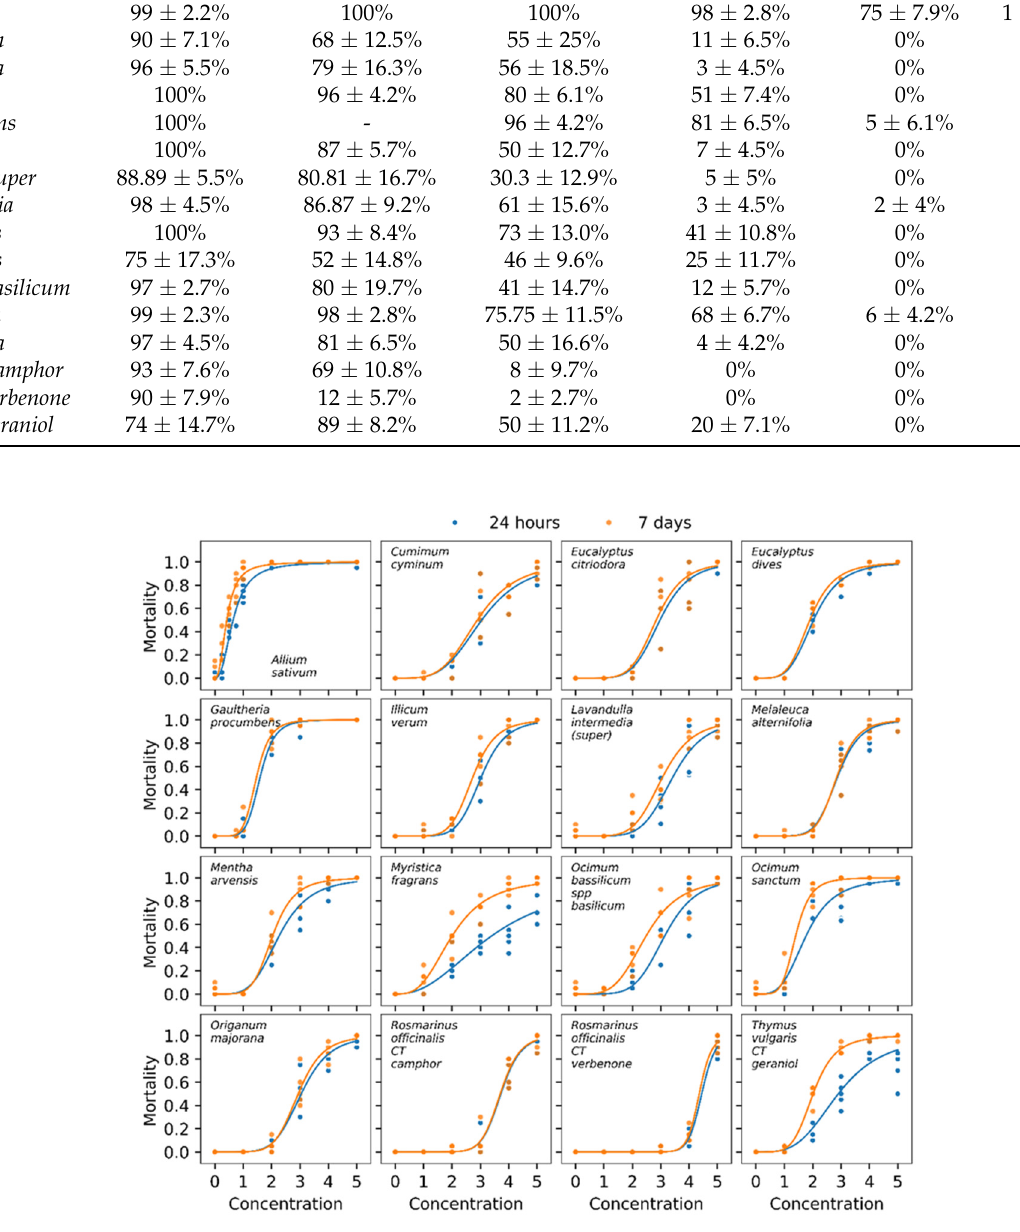
Figure 1. Mortality curves of EOs tested on S. granarius 24 h after treatment (blue) and 7 days after treatment (orange).